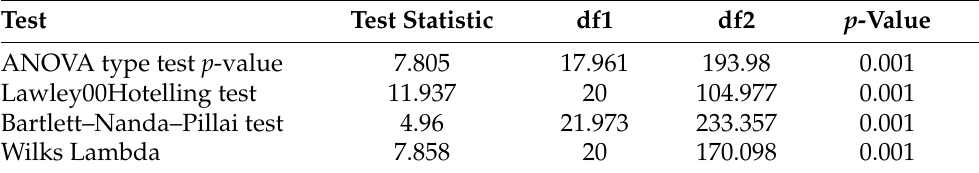
Table 5. Multivariate non-parametric test